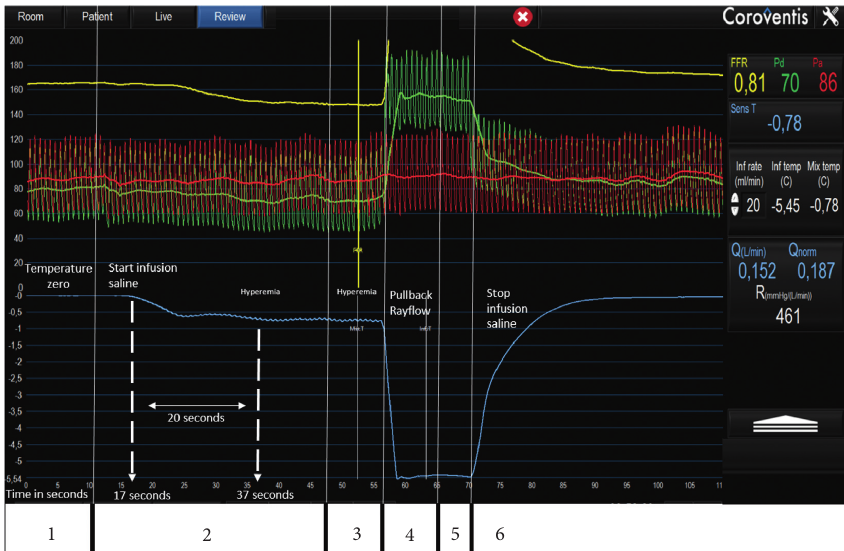
Figure 4: Measurement screen, step-by-step. This figure shows the software screen during the flow and resistance measurement. Panel 1: the temperature measured by the pressure wire is zeroed, which means it is calibrated at body temperature. Panel 2: the infusion of saline starts at 20ml/min in this case; the fast decrease in temperature is visible here. Panel 3: steady-state maximum hyperemia has been reached here and T is recorded. Panel 4: the pressure wire is pulled back to the tip of the Rayflow to measure the infusion temperature of the saline. This pullback is indicated by the fast decrease in temperature and sudden increase in distal pressure. Panel 5: the infusion temperature measurement reaches steady state and T i is calculated. Panel 6: the infusion pump is stopped and the temperature of the blood reaches starting values within 30 seconds. Further, the timeline in the figure indicates the time in seconds. Here, it can be appreciated that it takes approximately 20 seconds for hyperemia to occur. Red tracing: aortic pressure; green tracing: distal coronary pressure; blue tracing: coronary temperature. The numerical values of all relevant parameters are displayed in the right side of the Coroventis screen . T i : the infusion temperature of the saline as measured at the infusion holes of the Rayflow catheter; T : the distal coronary temperature after complete mixing of blood and saline measured by the pressure wire after calibration to body